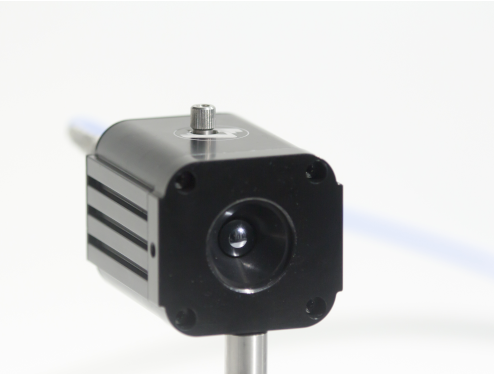
Figure 2. Photo of silicon lens coupled FET-based THz detector equipped with low-noise amplifier. Courtesy of MB “Terahertz Technologies”, Vilnius,